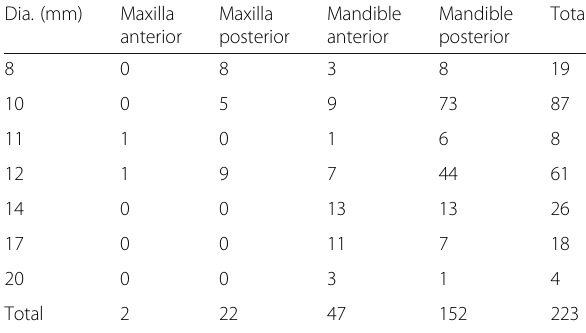
Table 4 Distribution of implants by length and location ( n = 223) Dia. (mm)